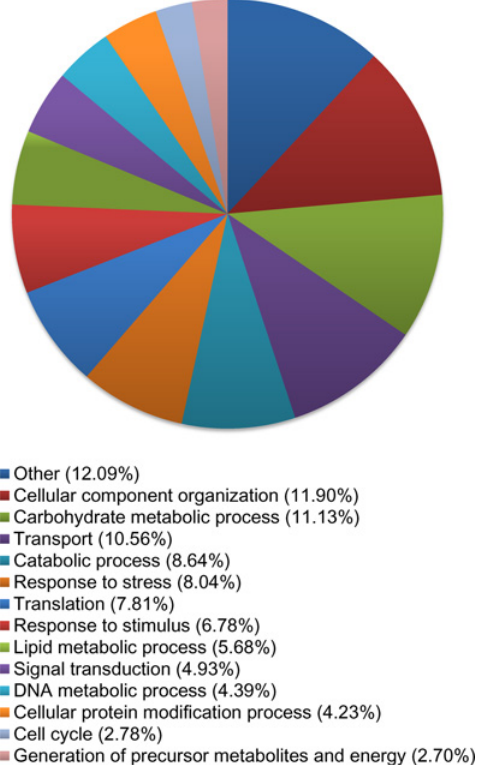
Fig 4. Percentage of transcripts in Betula papyrifera control samples. A total of 21,793 transcripts were assigned gene ontology and grouped by biological function using BLAST2GO. Categories under 2% were grouped together and classified as “ other ”